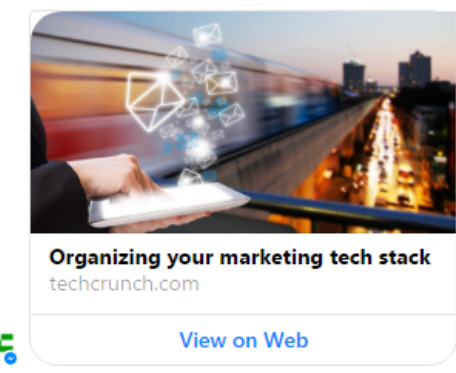
Fig. 9. TechCrunch’s card with an